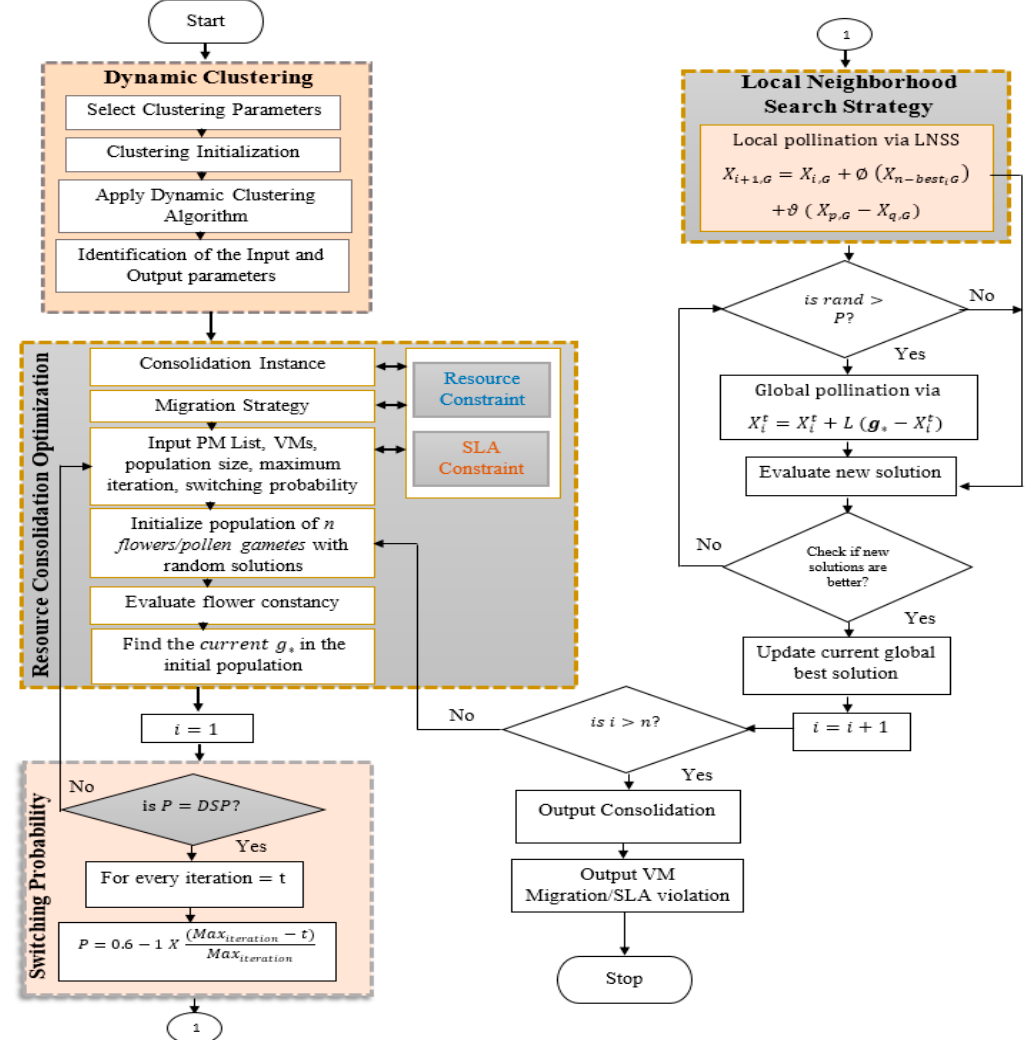
Figure 4. Proposed MOH-FPRC algorithm.